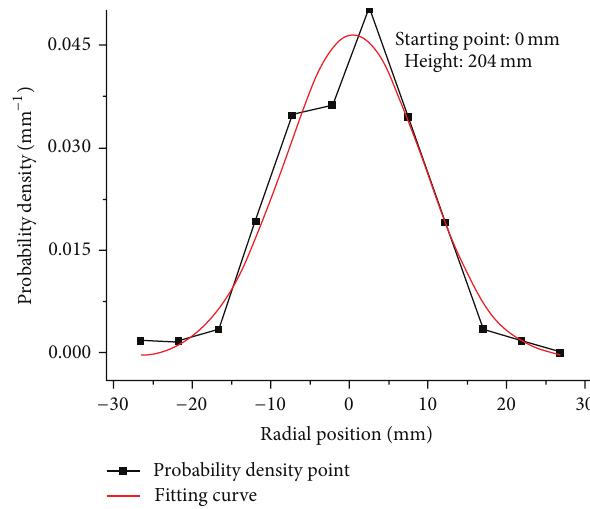
Figure 5: Gaussian fitting curve on probability density of radial